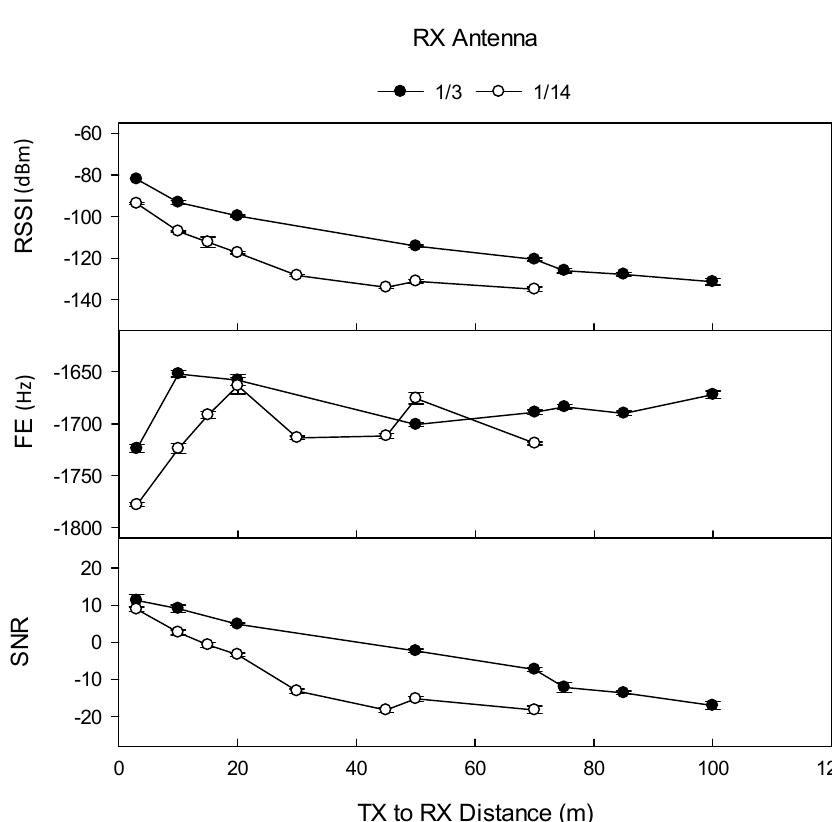
Figure 9. Effect of RX antenna type on signal quality, Site 3 (Dermosol) (0.2 kbps data rate, TX buried